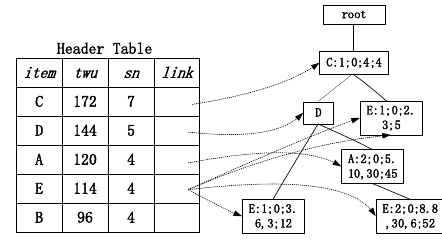
Figure 3. After removing node B